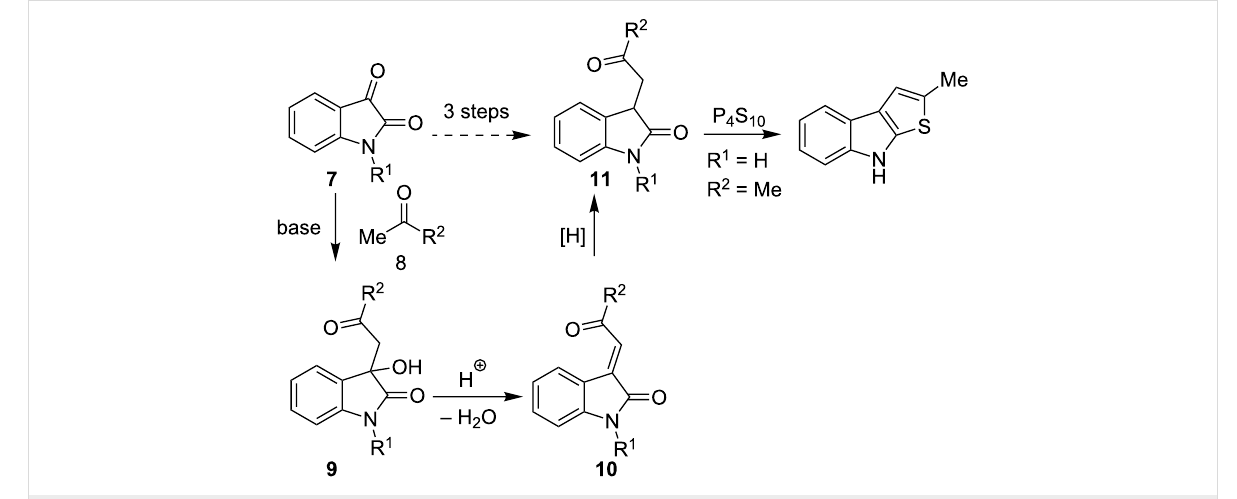
Scheme 2: Synthesis and thionation of indodin-2-ones 11 .